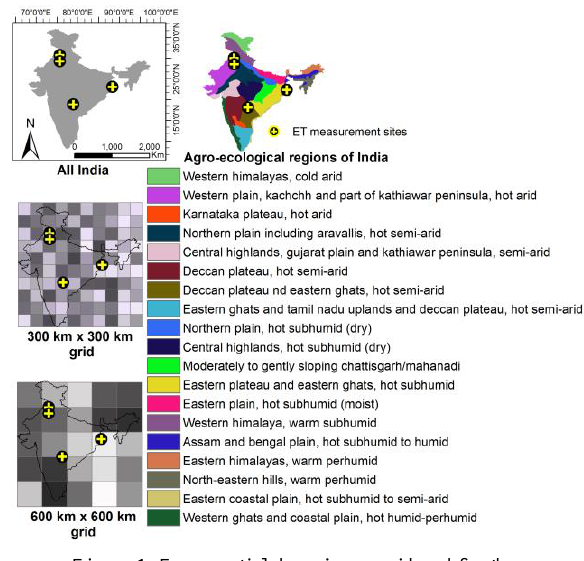
Figure 1. Four spatial domains considered for